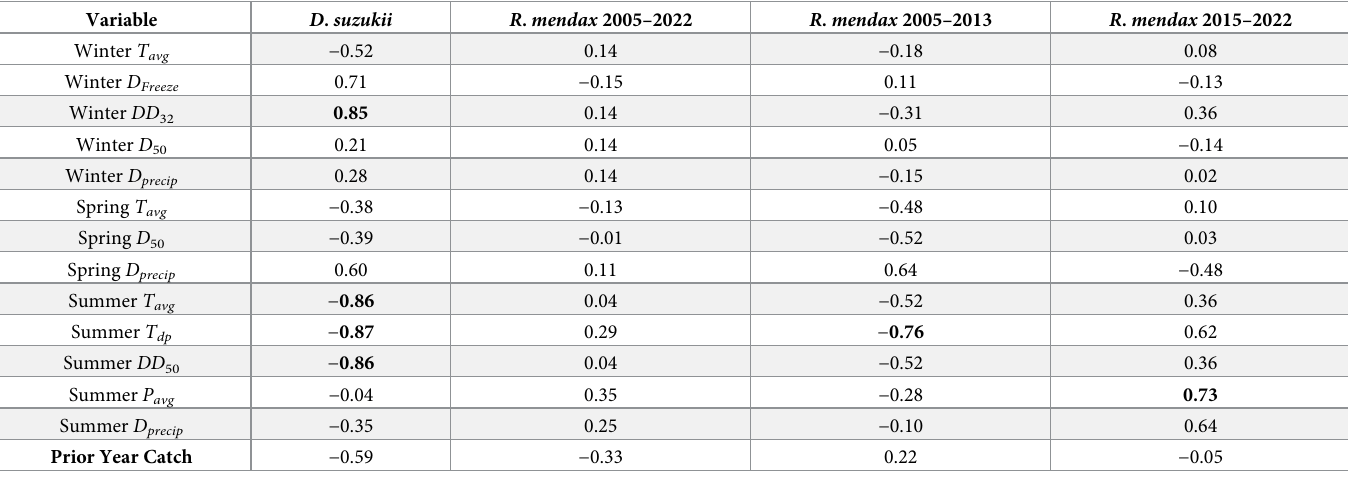
Table 4. Selected Pearson correlation coefficients ( r ) of Rhagoletis mendax and Drosophila suzukii annual first capture dates with seasonal climate variables. Three time periods are presented for R . mendax to correspond to before and after D . suzukii invasion and across the entire time period. Variable